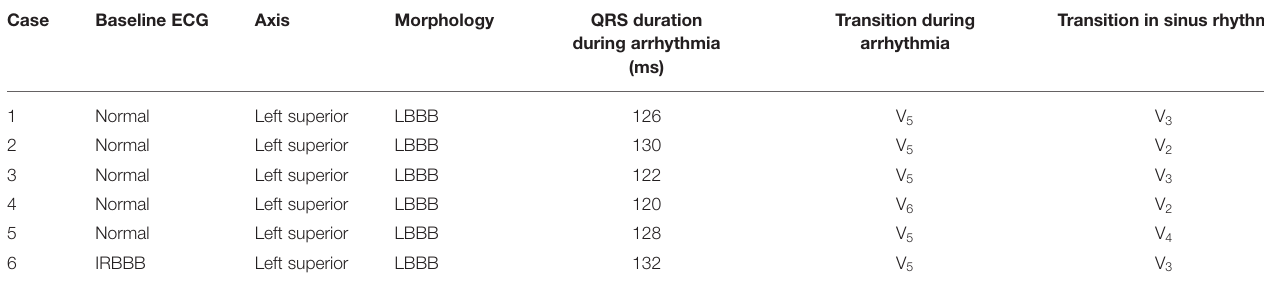
TABLE 2 | Electrocardiographic